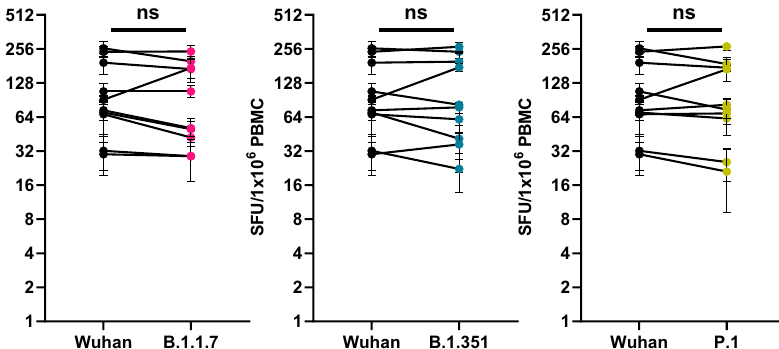
Fig. 2 INO-4800 cellular immune response against SARS-CoV-2 variants. PBMCs from 10 Phase 1 subjects were collected 8 weeks after receiving the second dose of INO-4800 (n = 5 , 1.0 mg ; n = 5, 2.0 mg). PBMCs were treated with peptide pools spanning the entire Spike proteins of the Wuhan, B.1.1.7, B.1.351, or P.1 variants, and cellular responses were measured by IFN γ ELISpot assay. Mean ± s.e.m. IFN γ SFUs/ million PBMCs of experimental triplicates are shown. ns not signi fi cant (Wilcoxon signed-rank